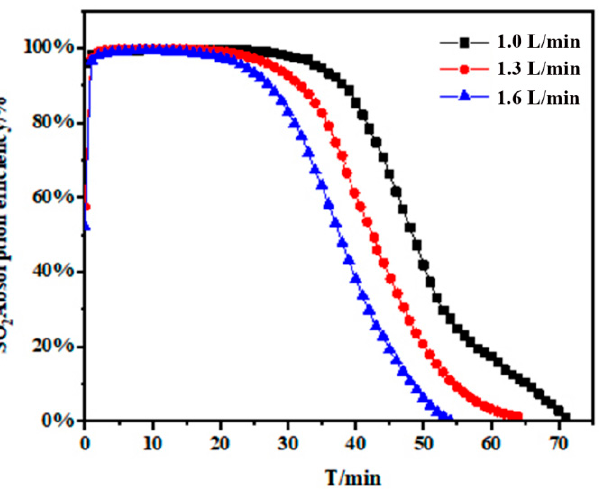
Figure 7. Effect of the gas flow rate. SO 2 = 2300 ppm, absorption solution = 60 mL, Ci-Na = 0.06 mol/L and HA–Na = 0.2 g and 25 ◦ and HA–Na = 0.2 g and 25 ° C.